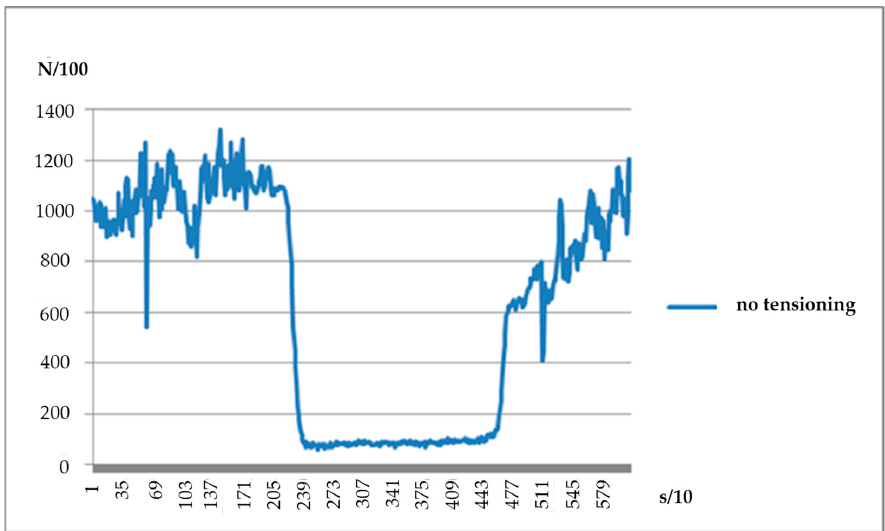
Figure 11. Tension force measurement without force control.